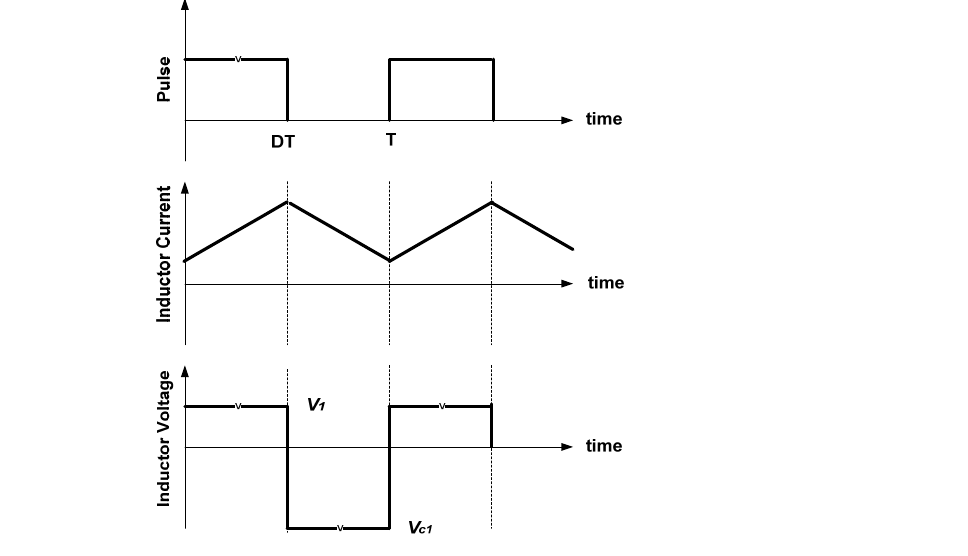
Figure 3. Schematic diagram showing the inductor current and voltage across it with pulse variation considering continuous current mode.